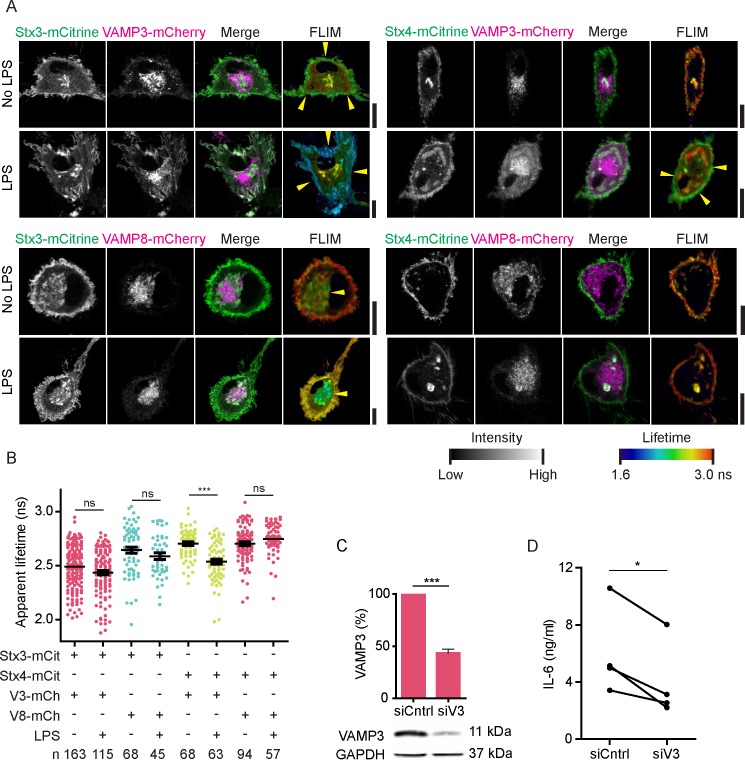
LPS activation of dendritic cells increases complex formation of Stx4 with VAMP3 at the plasma membrane.(A) Representative confocal microscopy (left) and convoluted FLIM (right) images of unstimulated or LPS-activated dendritic cells expressing Stx3-mCitrine or Stx4-mCitrine (green in merge) with VAMP3-mCherry or VAMP8-mCherry (magenta). Apparent fluorescence lifetimes of Stx3-mCitrine and Stx4-mCitrine with VAMP3-mCherry were lowest at the cell membrane (yellow arrowheads), whereas the lifetimes of Stx3-mCitrine with VAMP8-mCherry were lowest at intracellular compartments (yellow arrowheads). Scale bars, 10 µm. Lifetime images are in Figure 5—figure supplement 1A. (B) Whole-cell apparent fluorescence lifetimes for the conditions from panel A in presence or absence of LPS. Shown are individual cells pooled from at least 4 donors (mean ± SEM shown; one-way ANOVA with Bonferroni correction; n: number of cells; individual donors in Figure 5—figure supplement 1D). (C) Representative Western blot and quantification of siRNA knockdown of VAMP3 (siV3; p=0.0001, paired two-sided Student’s t-test). siCntrl: non-targeting siRNA control. GAPDH: loading control. (D) IL-6 production after 24 hr LPS exposure by dendritic cells with VAMP3 knockdown (siV3) or siCntrl (individual donors shown; p=0.0199, paired two-sided Student’s t-test; time traces shown in Figure 5—figure supplement 1E).